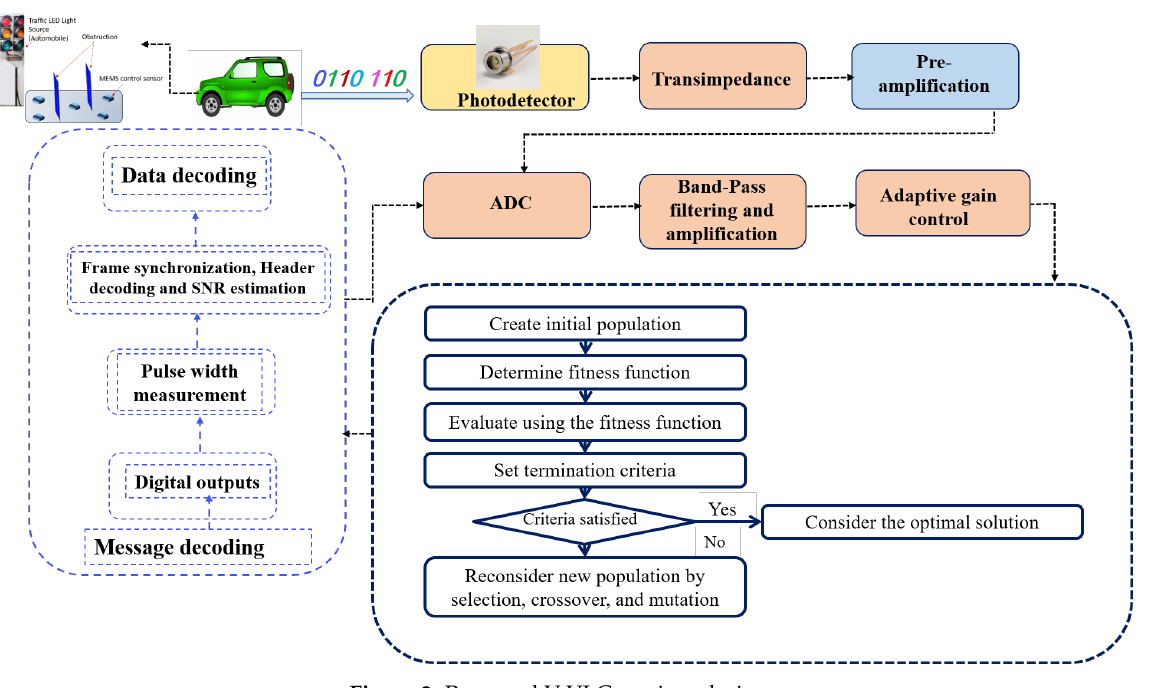
Figure 2. Proposed V-VLC receiver